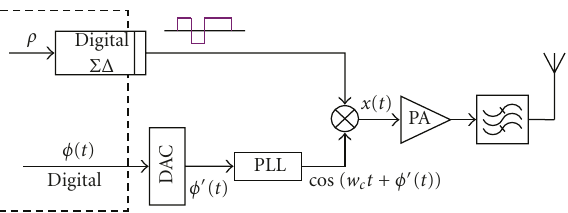
Figure 3: Architecture of the modified polar ΣΔ transmitter.